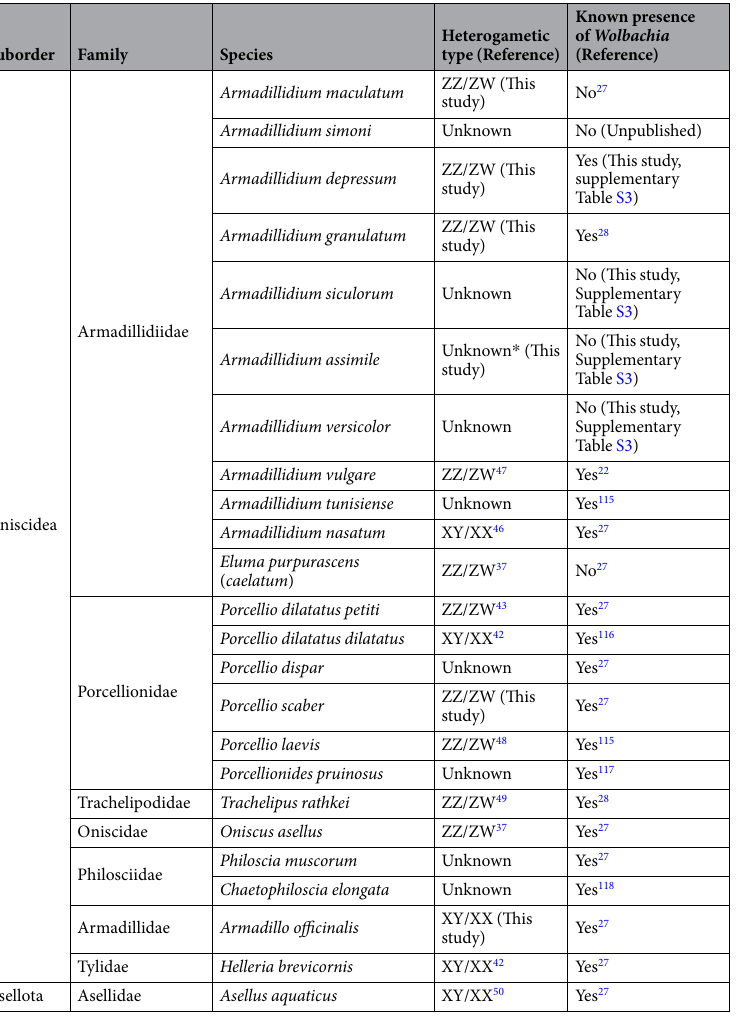
Table 1. Heterogametic types found in isopod crustaceans. ( * considered as unknown because crossings of sex reversed individuals yielded inconclusive results with respect to our predictions for XY/XX and ZZ/ZW